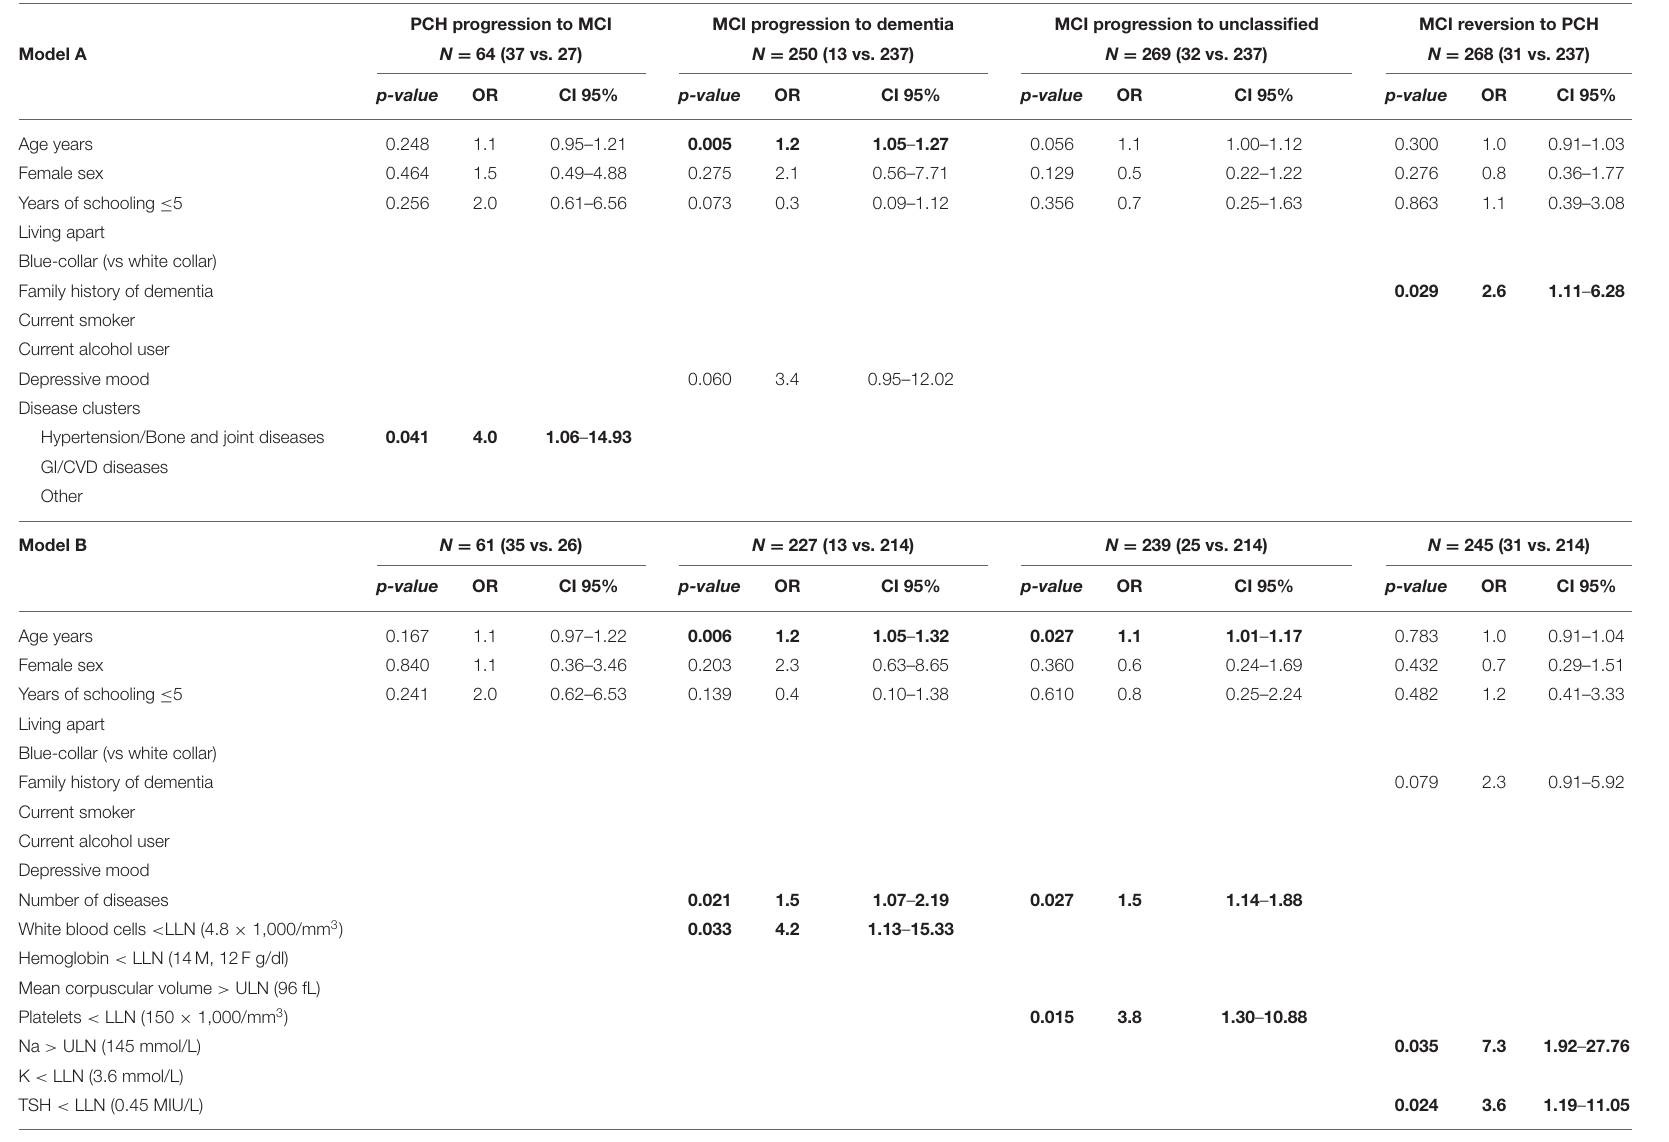
TABLE 3 | Predictors of cognitive progression or reversion from preserved cognitive health or mild cognitive